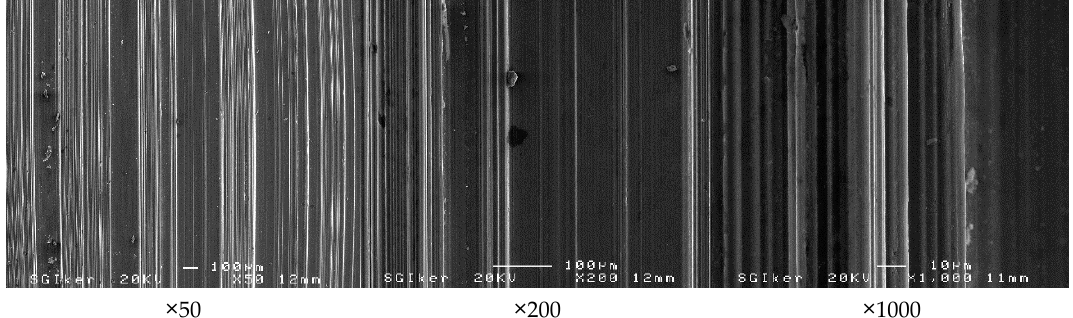
Figure 18. AA ‐ 5754 ‐ F380 disk.